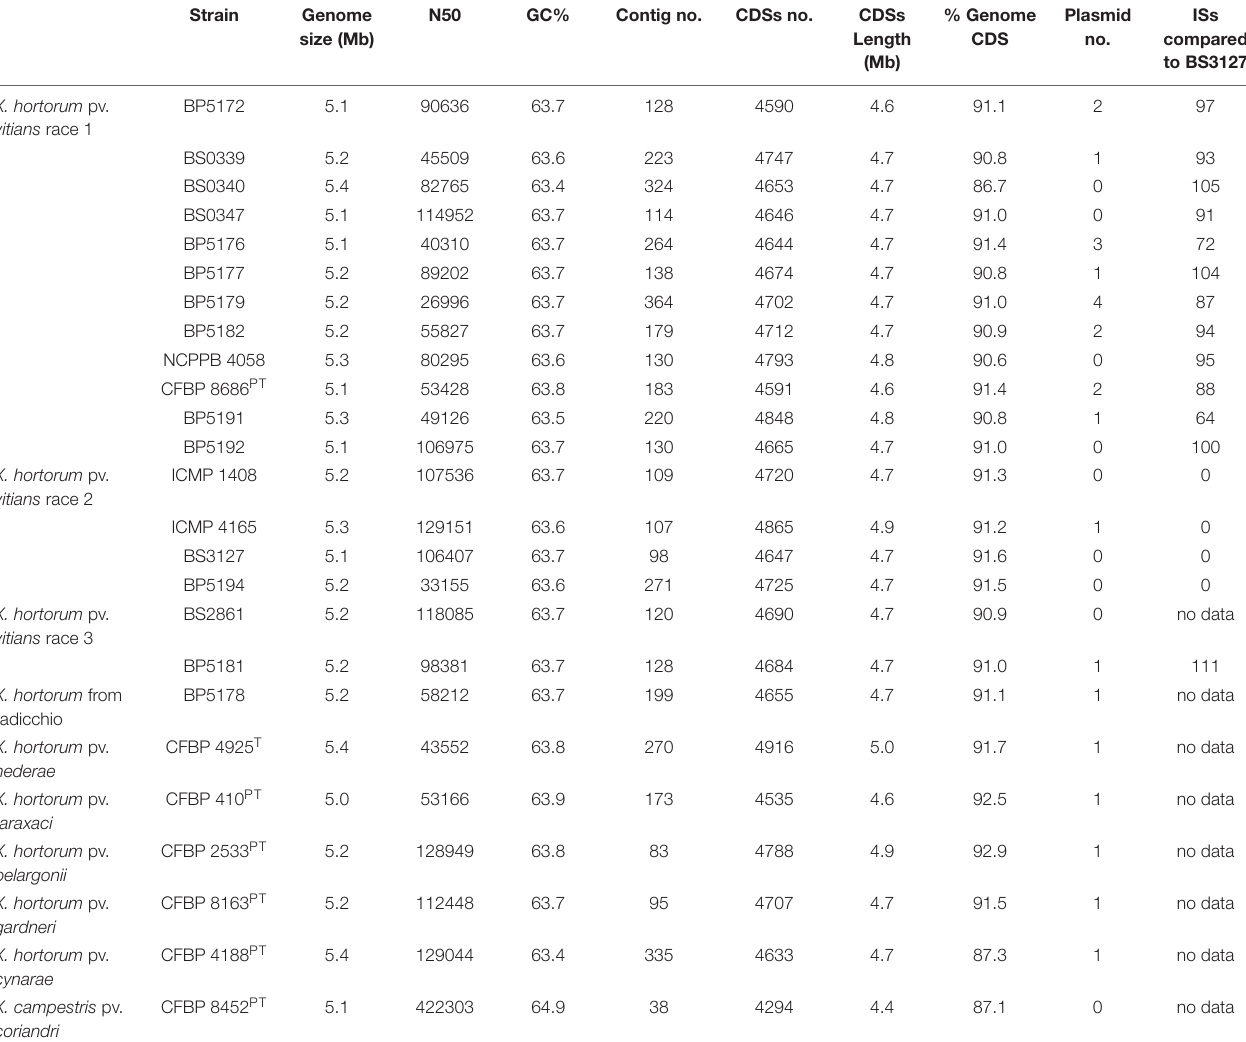
TABLE 2 | Genome characteristics for Xanthomonas hortorum pv. vitians strains and related type and pathotype strains.